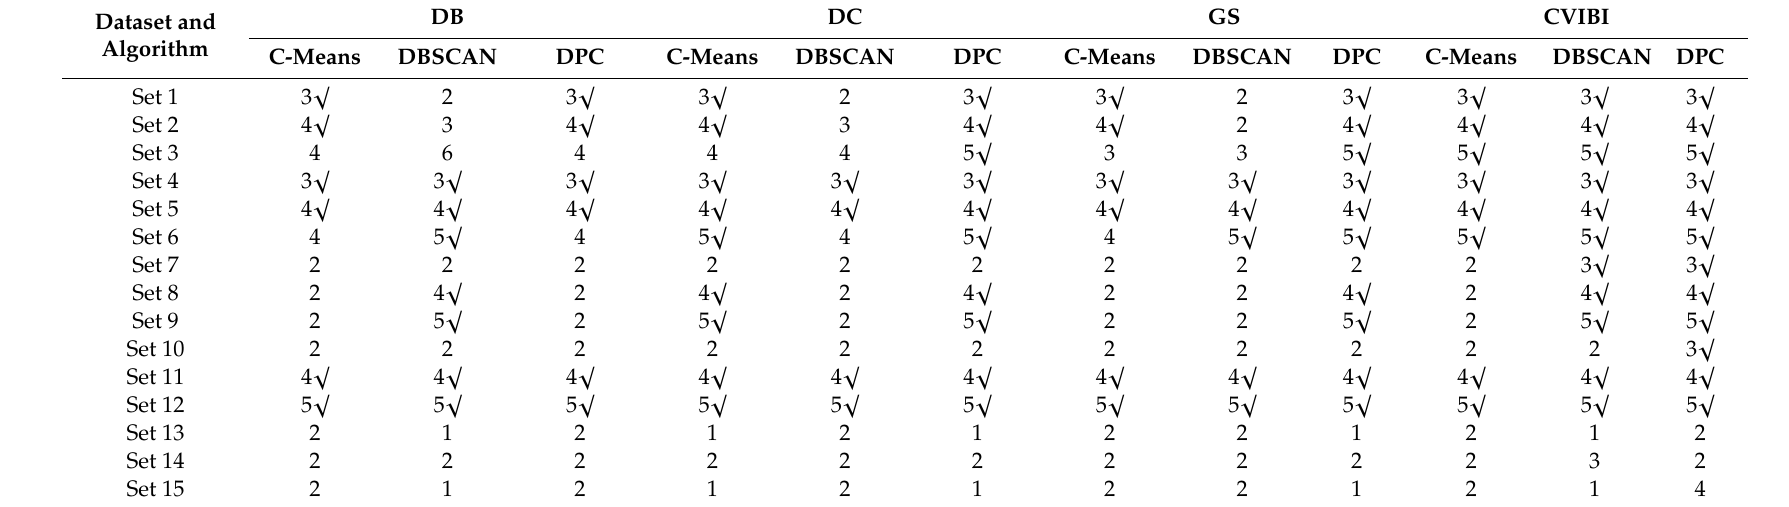
Table 3. Evaluation of clustering results by CVIBI, Davies–Bouldin (DB), dual-center (DC) and gap statistic (GS) for 15